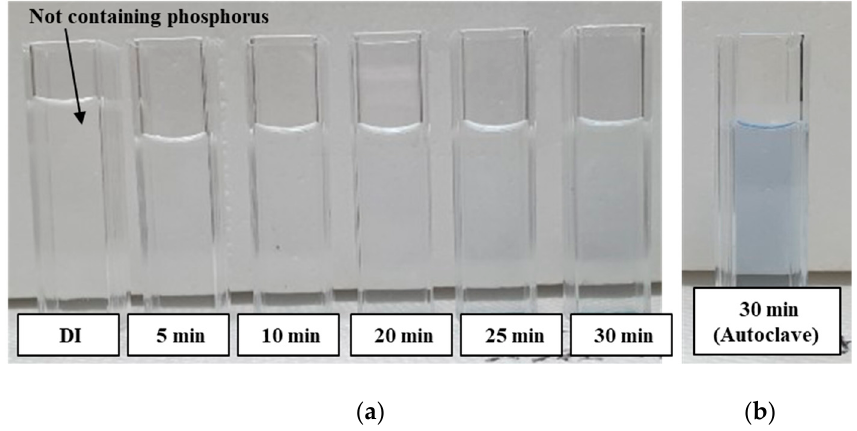
Figure 9. ( a ) Pretreated and colorized analytes (2 mg/500 mL) using a miniaturized portable TP analysis device with pretreatment times (UV operating current: 40 mA), and ( b ) pretreated and colorized analytes (2 mg/500 mL) using the autoclave.